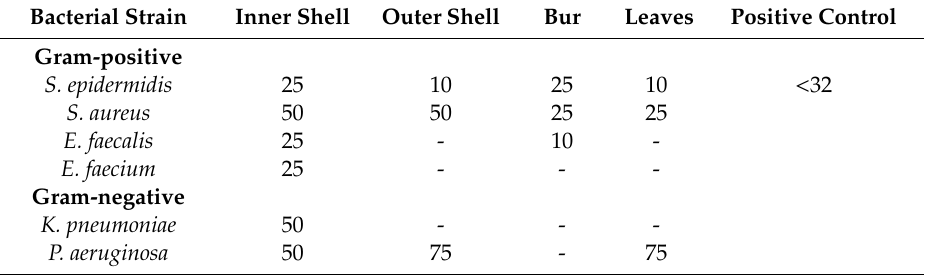
Table 5. Minimum inhibitory concentration (MIC, mg / mL) of the ethanolic extracts from chestnut inner and outer shells, bur, and leaves against multidrug resistant Gram-positive and Gram-negative